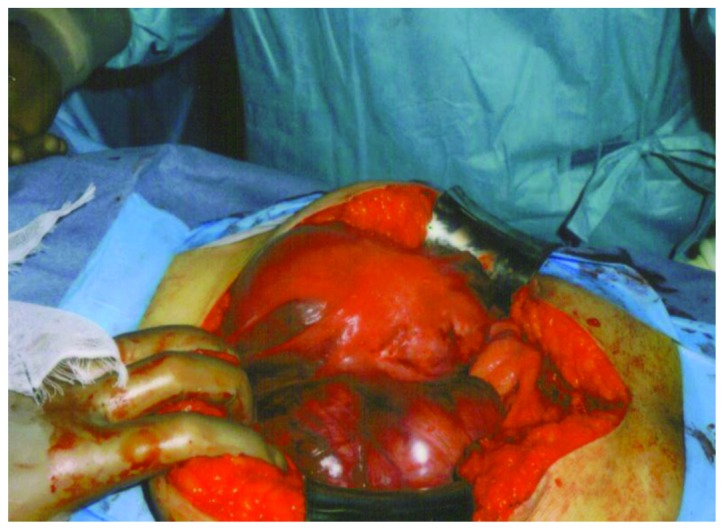
Exploratory laparotomy revealed a large tumor extending outside of the pelvis and invading the colon.